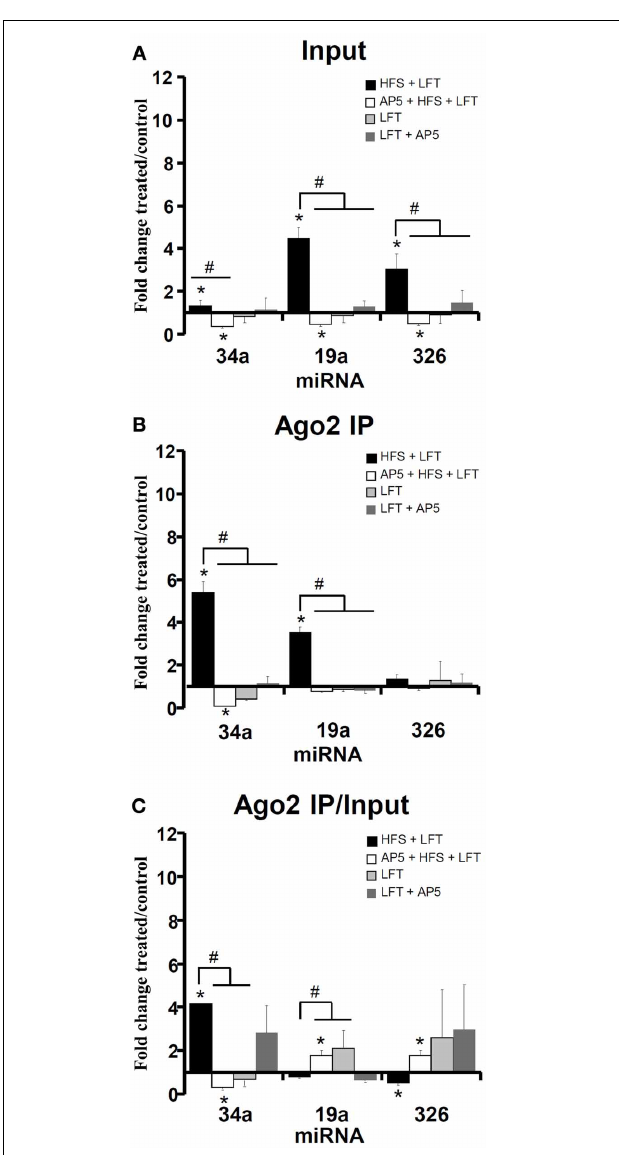
FIGURE 4 | Regulation of Arc -targeting miRNAs in LTP. Quantitative PCR was used to examine the expression of a set of 3 Arc -associated miRNAs at 30min. The same set of miRNAs were analyzed in the input sample (A) and Ago2 immunoprecipitate (B) . The qPCR data was normalized to the expression of miR-345-3p. (A) Fold change in Arc -associated miRNA expression in dentate gyrus lysates at 30min post-HFS. Bar graph shows mean fold change ( + s.e.m.) in treated dentate gyrus relative to control, contralateral dentate gyrus. HFS + LFT, n = 6; AP5 + HFS + LFT, n = 4; LFT alone, n = 5; AP5 + LFT, n = 5. Significant differences between the HFS group and other treatment groups are indicated (#; p < 0 . 05). Significant difference between the ispilateral (treated) and contralateral (control) dentate gyrus are indicated ( ∗ ). (B) Fold change in Arc -associated miRNA expression in dentate gyrus Ago2 immunoprecipitates at 30min post-HFS. Significant differences between the HFS group and other treatment groups are indicated (#; p < 0 . 05). Significant difference between the ispilateral (treated) and contralateral (control) dentate gyrus are indicated ( ∗ ). (C) Relative fold change in Arc -associated miRNA expression in dentate gyrus Ago2 immunoprecipitates compared to dentate gyrus lysates (Ago2/input